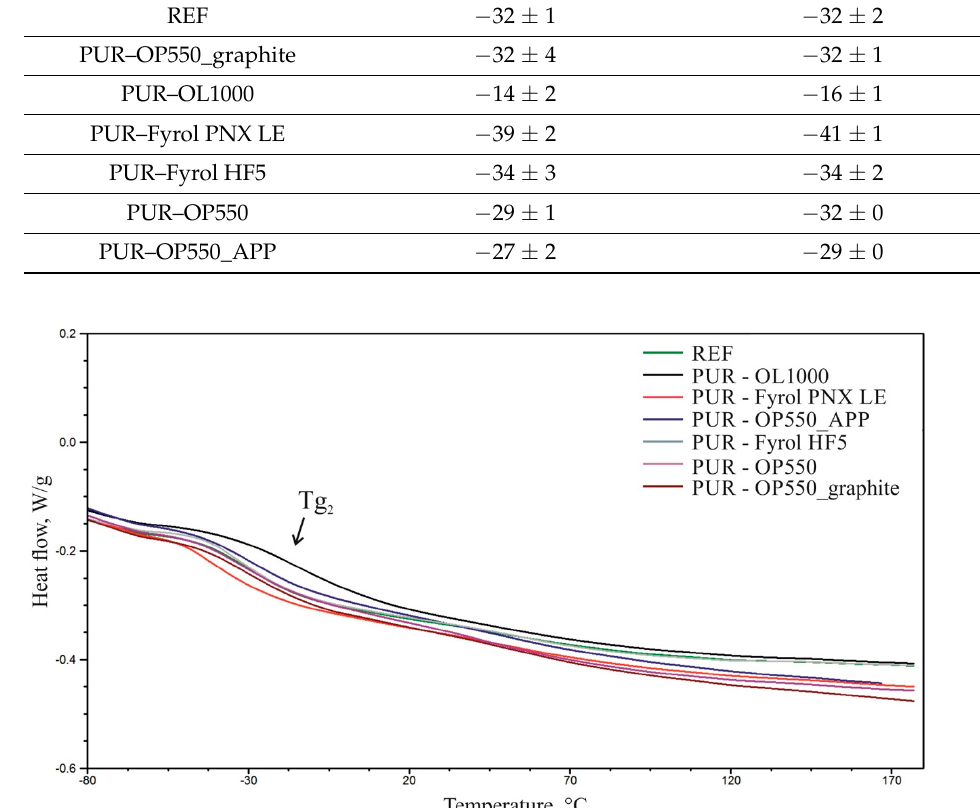
Figure 6. Summary of thermograms obtained during the second heating of the samples.